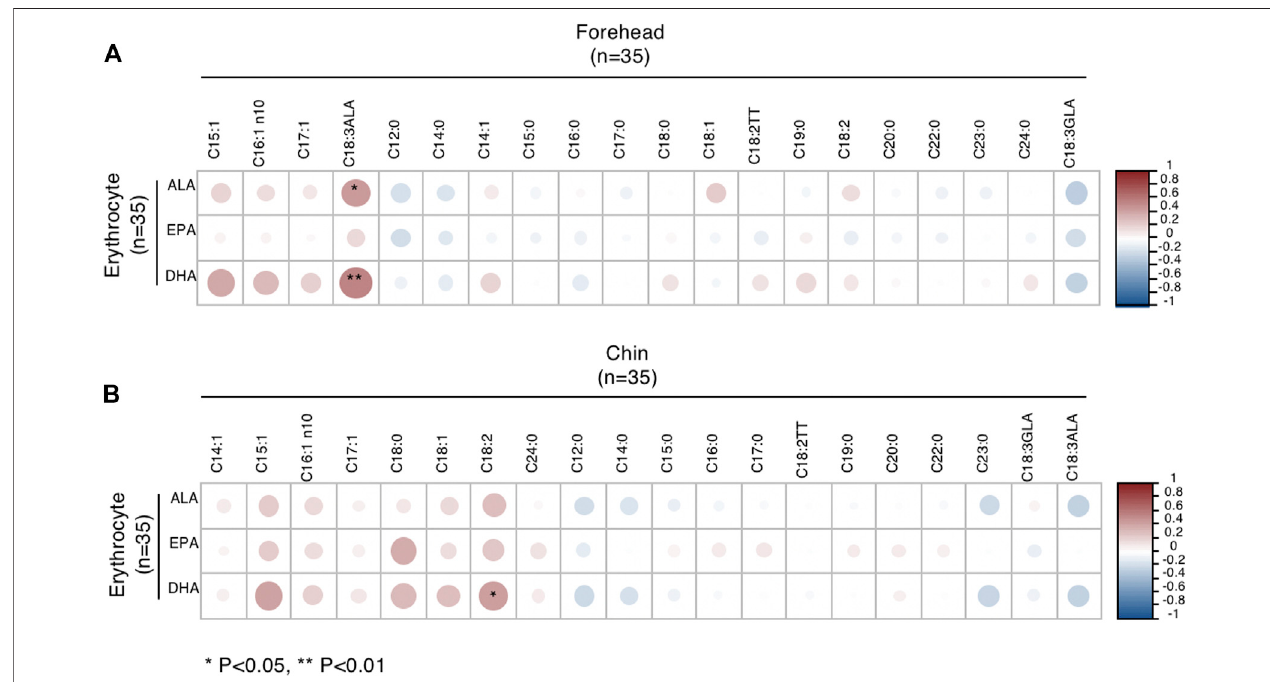
FIGURE 3 | Correlations between Omega-3 PUFA of erythrocytes and FA ofsebum from the forehead (A) and chin (B) in male subjects. * p < 0.05 and ** p < 0.01.